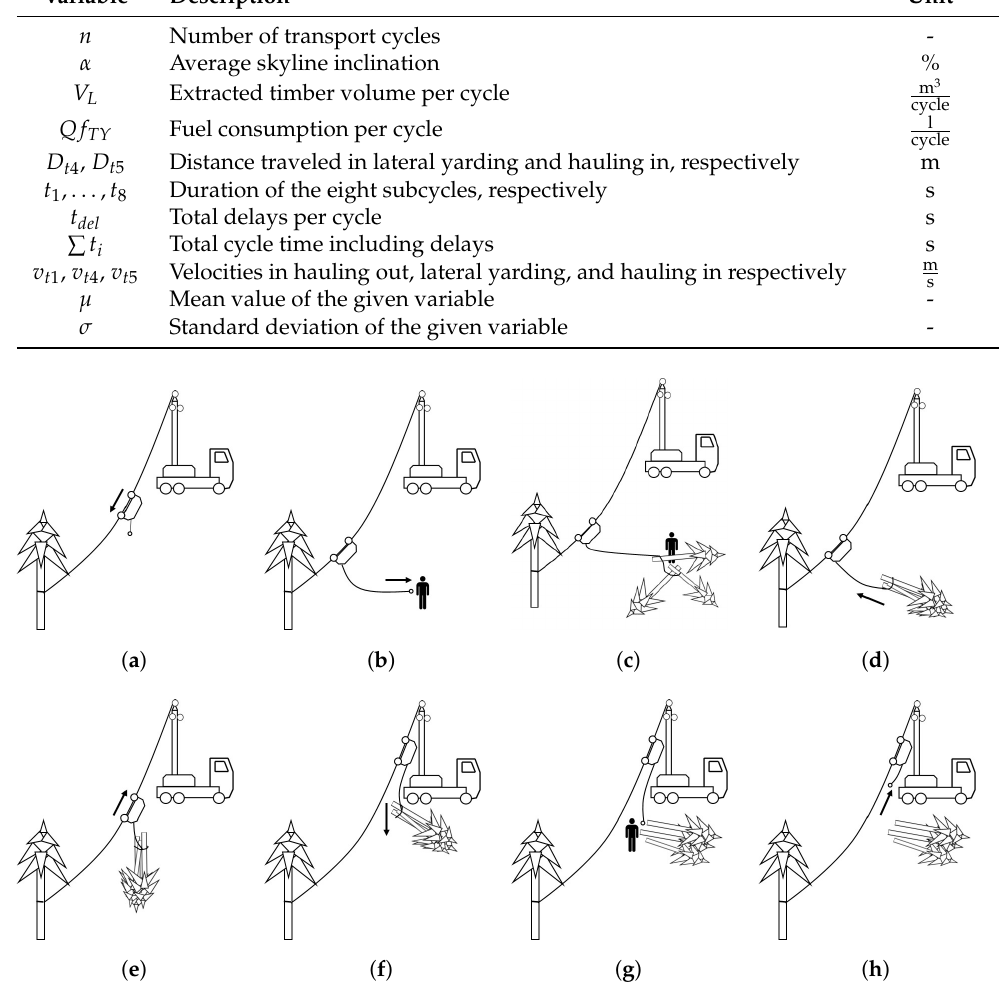
Figure 4. The eight subcycles which make up a complete cable logging transport cycle. ( a ) Hauling out. ( b ) Lowering the hook. ( c ) Hooking. ( d ) Lateral yarding. ( e ) Hauling in. ( f ) Lowering the payload. ( g ) Unhooking. ( h ) Lifting the